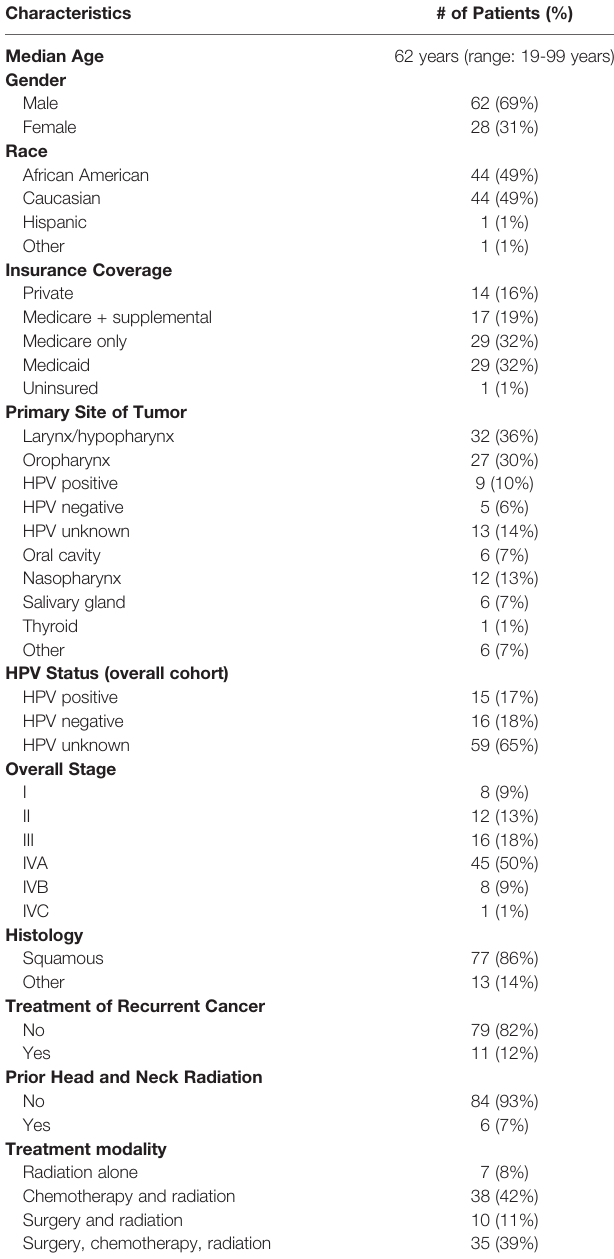
TABLE 1 | Patient demographics, tumor characteristics, and treatment characteristics of the study population (N=90).